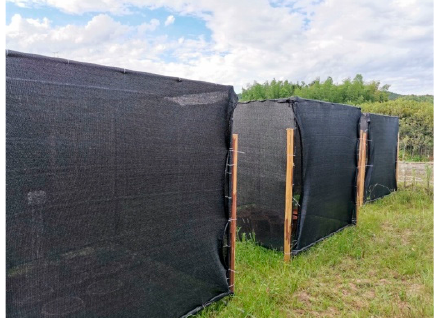
Figure 1. Glasshouse ( A ) and shade house ( B ) of the